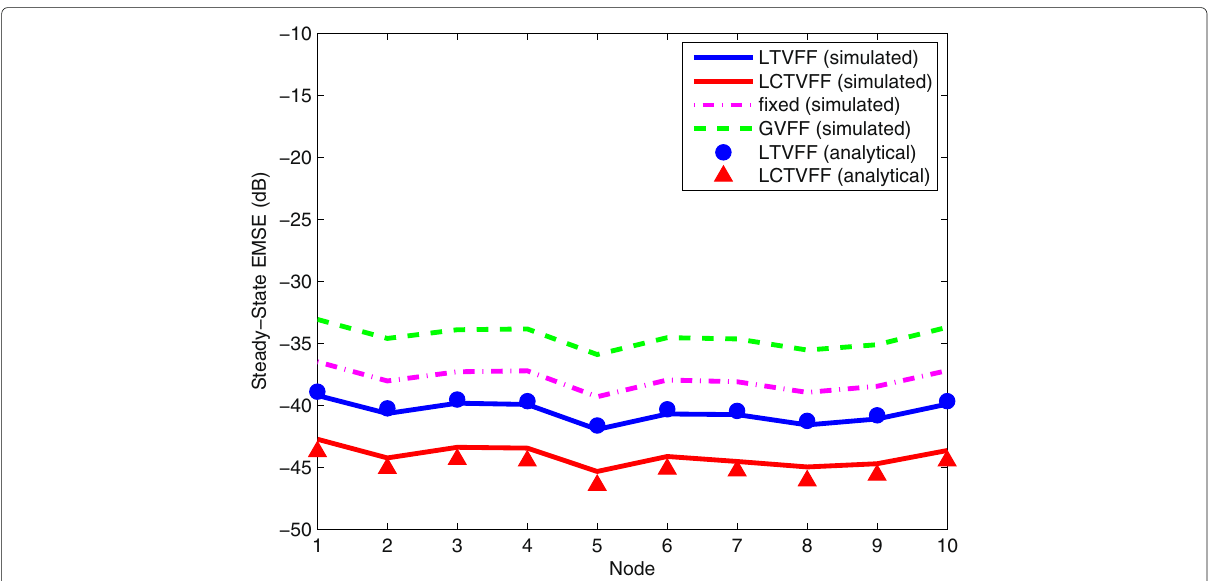
Fig. 13 Steady-state EMSE value versus node for the proposed and existing algorithms